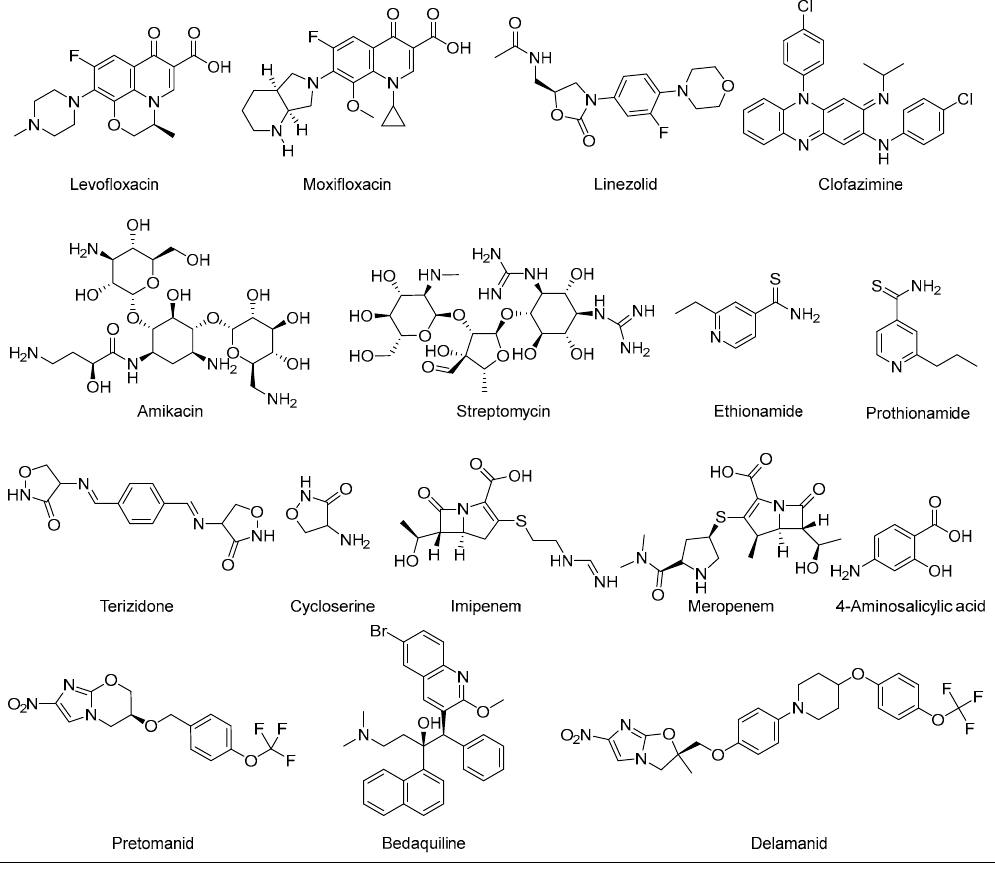
Figure 4 . Current second-line anti-TB agents. Figure 4. Current second-line anti-TB